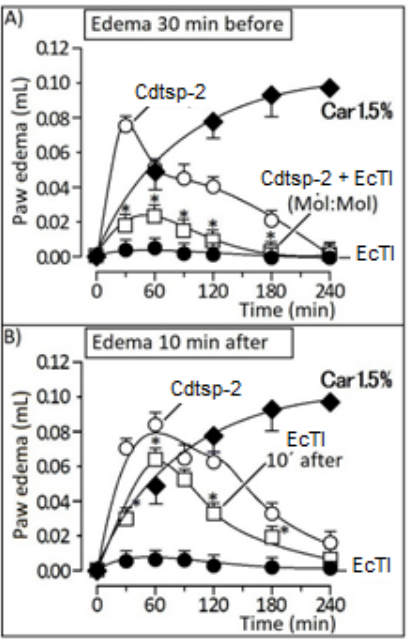
Figure 3. ( A ): Graph of paw edema volume ( µ L) of Swiss mice during inflammation, induced by the presence of Cdtsp-2 venom or the toxin with EcTi, which was injected 30 min before protein application. ( B ): Plot of the paw edema volume ( µ L) of Swiss mice during inflammation, induced by the presence of Cdtsp-2 or the toxin with EcTi injected 10 min after the protein application. Both assays were performed using 10 µ g of protein and 50 µ g of EcTi. Results were expressed as mean ± standard deviation ( n = 5), and treatments with significant difference marked with (*) (Two-way ANOVA, with Bonferroni as a posteriori test, F = 150.0 and p <